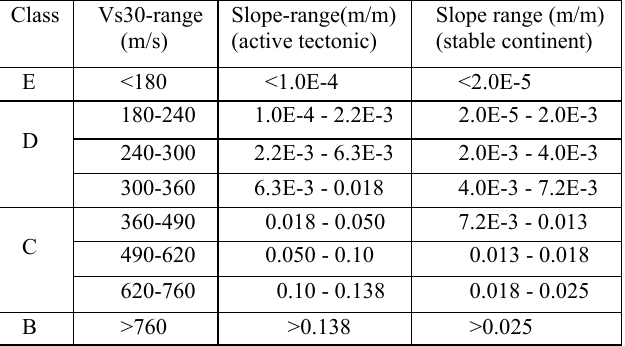
Table2. Summary of slope ranges for subdivided NEHRP Vs30 categories (Wald et al., 2007).